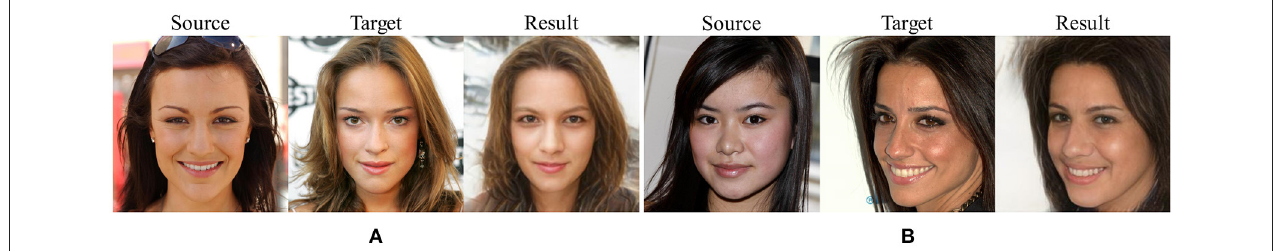
FIGURE 5 | Shortcomings of the proposed model. The problem in panel (A) is that the background of the conversion result is blurred. The problem in panel (B) is that the swapped face lacks Asian characteristics.